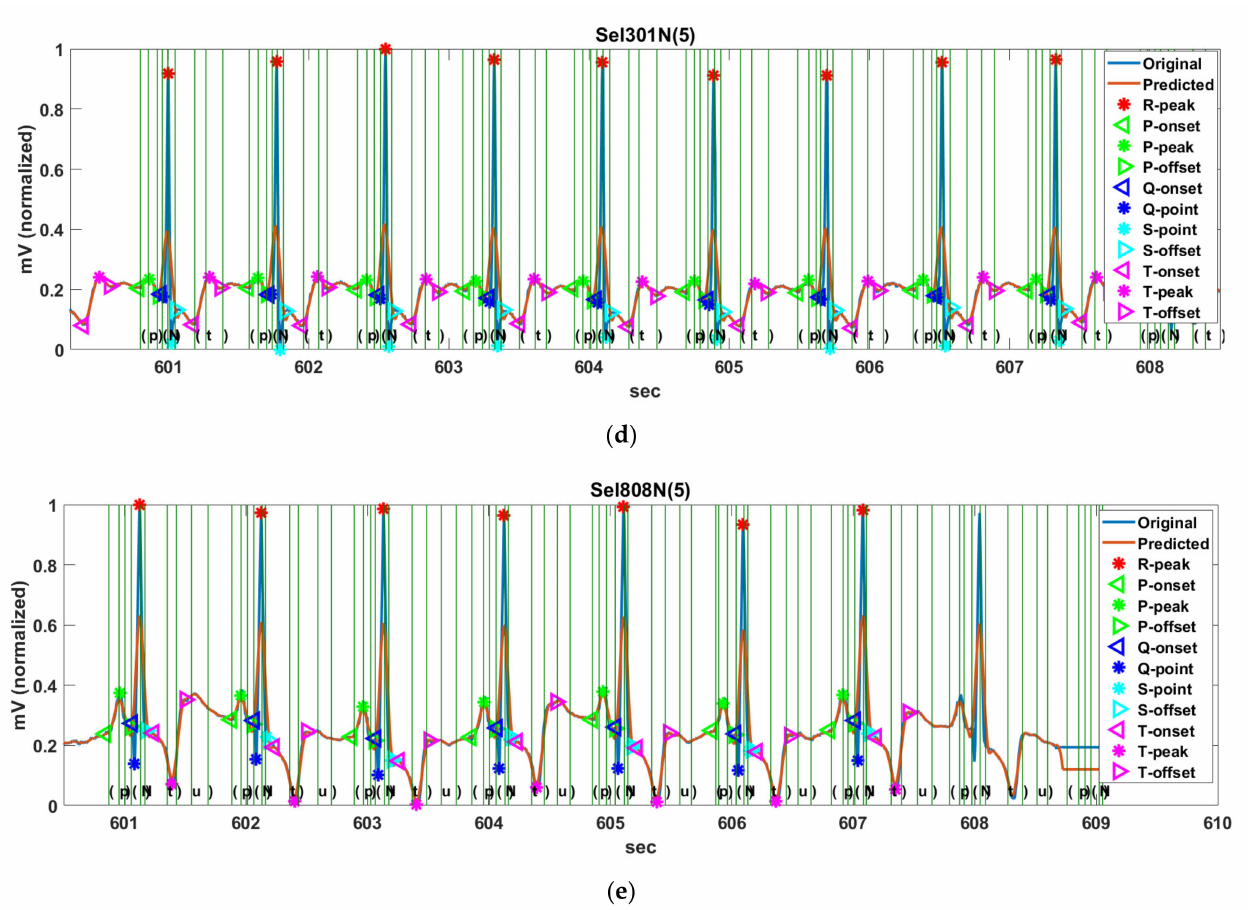
Figure 14. PQRST complex detection results of ( a ) Sel41N(5), ( b ) Sel231N(5), ( c ) Sel233N(5), ( d ) Sel301N(5), and ( e ) Sel808N(5) by the proposed method in